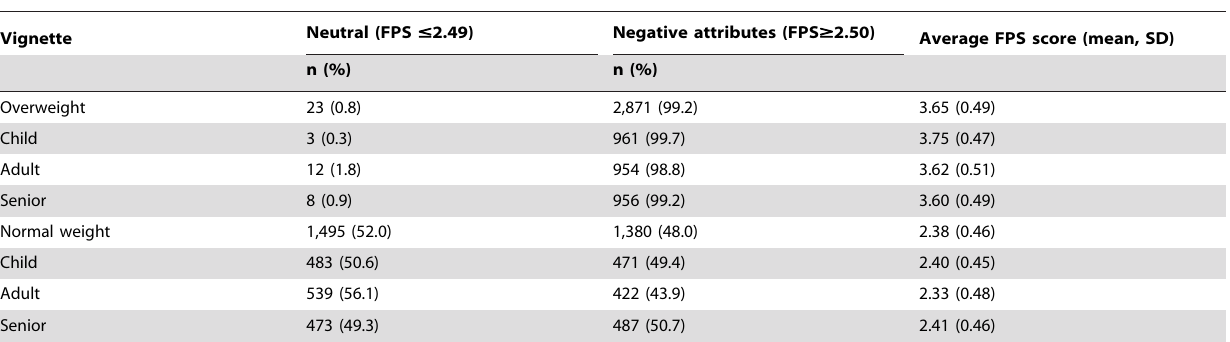
Table 4. Answer distribution patterns of mean FPS